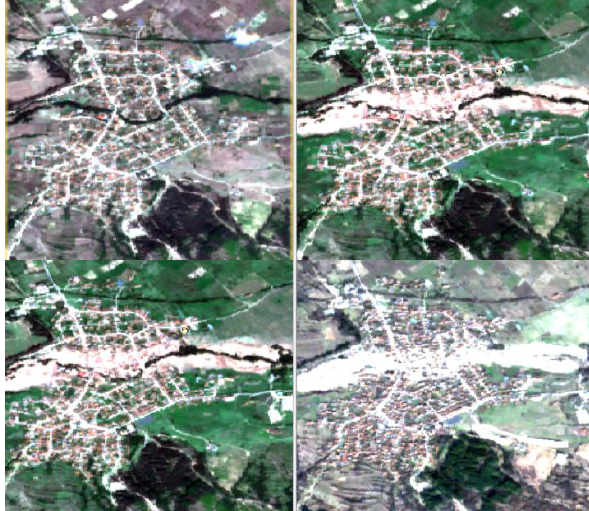
Figure 13. Karavelovo village. Photo from August 18, 2022 before the flood ( top left ); Photo from September 7, 2022 after the flood ( top right and bottom left ); photo from January 8, 2023 - 4 months after the disaster ( bottom right ).